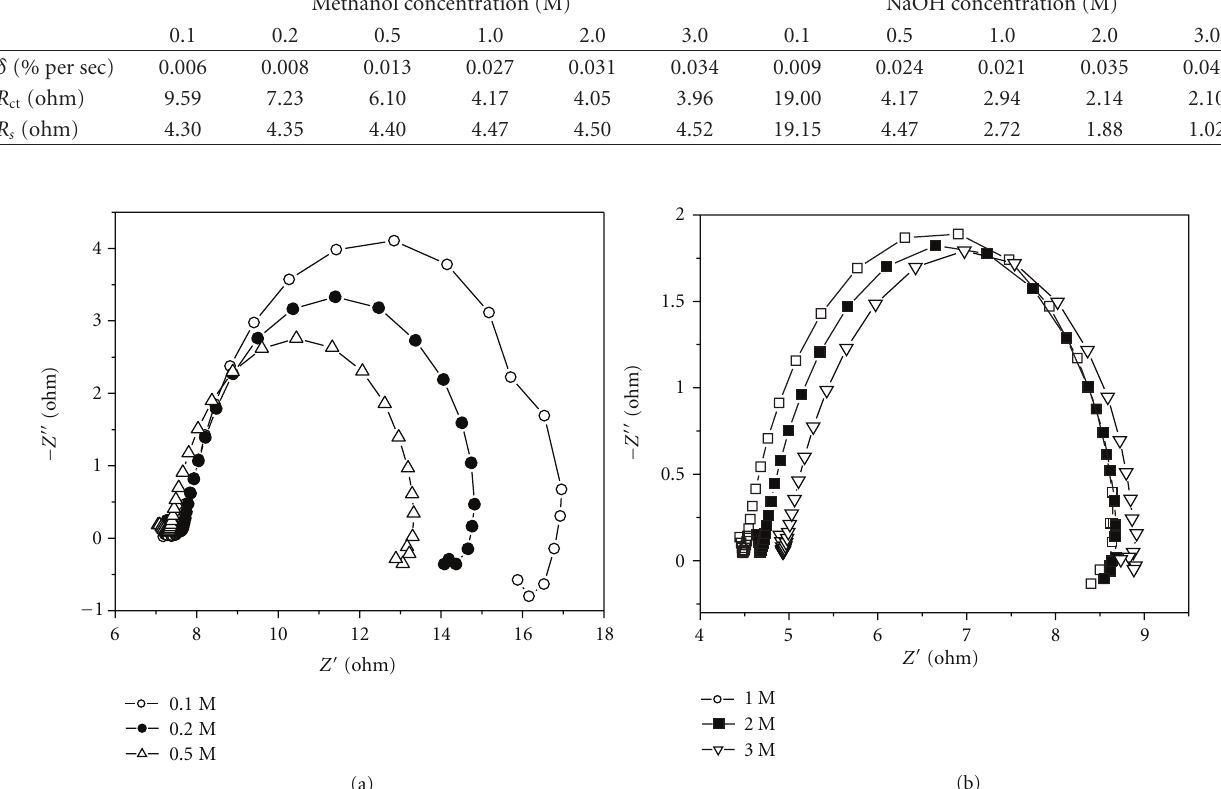
Figure 15: Impedance spectra (Nyquist plot) for methanol oxidation on Pt-Pd/C catalyst in 0.5 MNaOH with various concentrations of methanol at − 160 mV and 25 ◦ C.